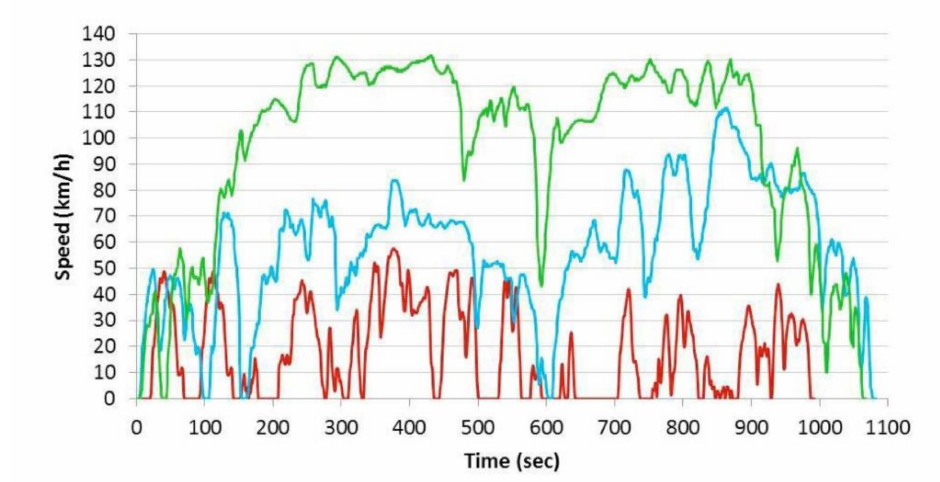
Figure 4. CADC Driving Cycle with urban section in red, extra-urban section in green and combined driving in light blue. Reprinted with permission from original publication: “What is the Most Representative Standard Driving Cycle to Estimate Diesel Emissions of a Light Commercial Vehicle?”, by Daniel Chindamo and Marco Gadola. IFAC-PapersOnLine, 51-5, pp. 73–78 (2018) [23] @2018 International Federa-tion of Automatic Control (IFAC).